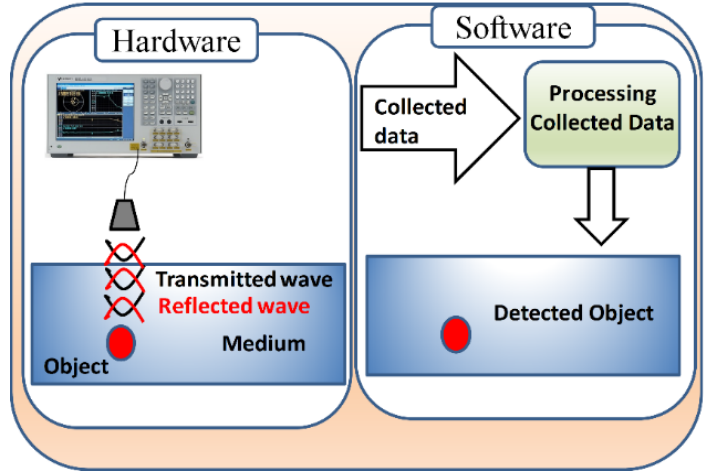
Figure 1. A schematic diagram showing the components of the microwave imaging (MI)